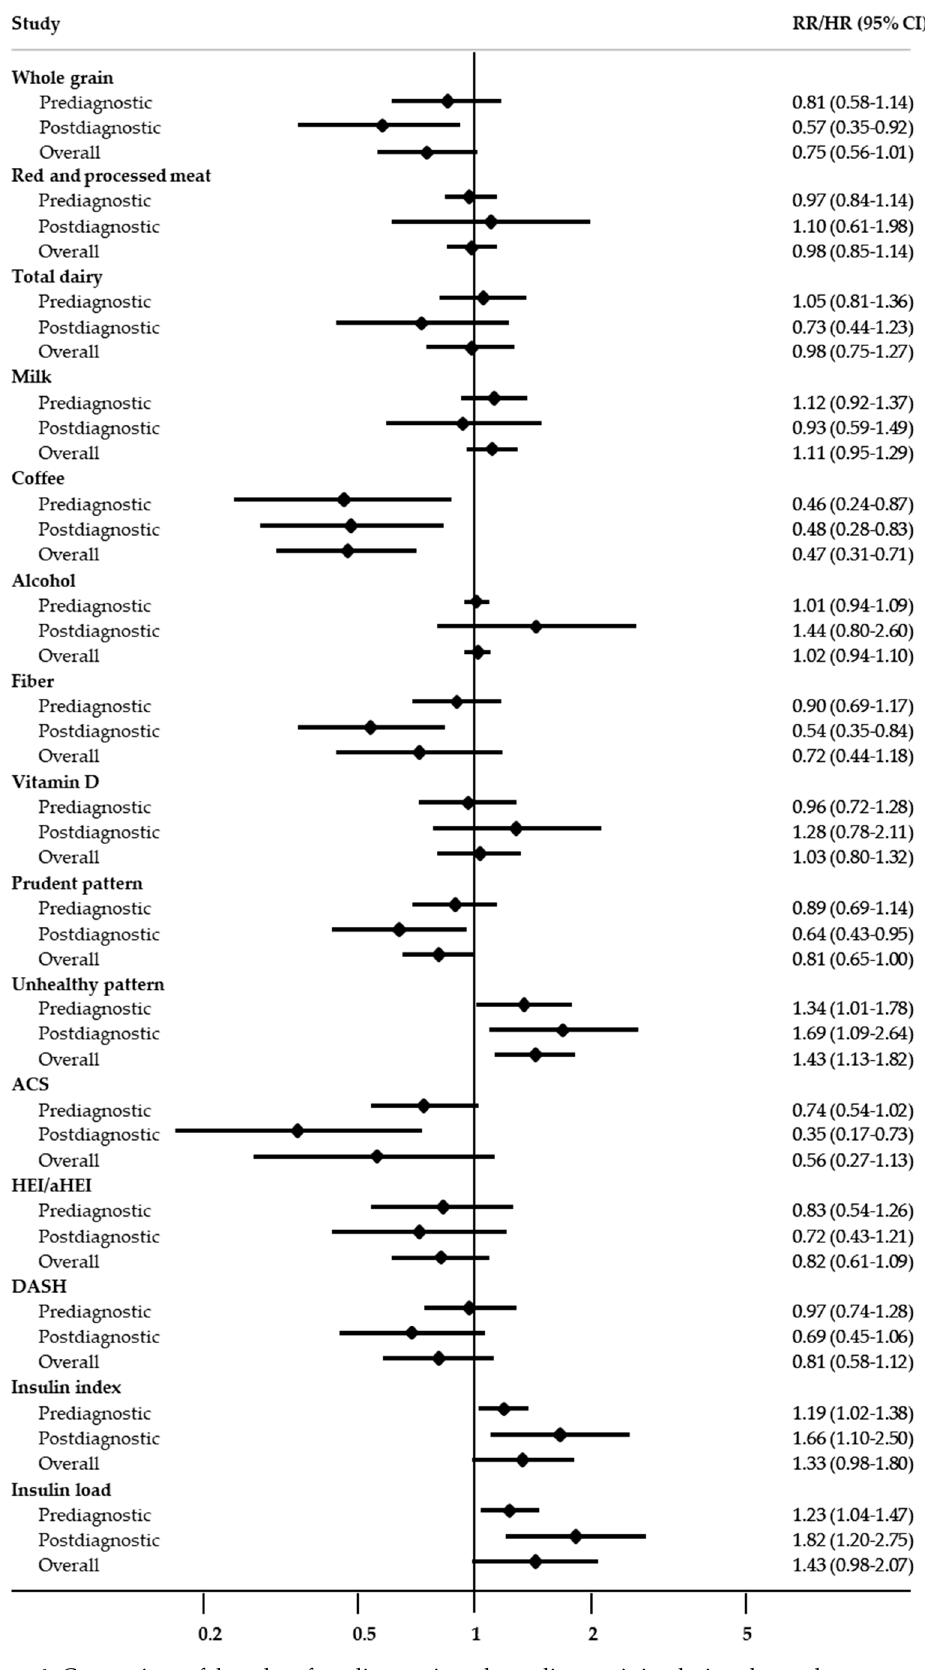
Figure 4. Comparison of the roles of prediagnostic and postdiagnostic intake in colorectal cancer-specific mortality. ACS, American Cancer Society recommendations score; DASH, Dietary Approaches to Stop Hypertension score; RR, relative risk; HR, hazard ratio; CI, confidence interval .